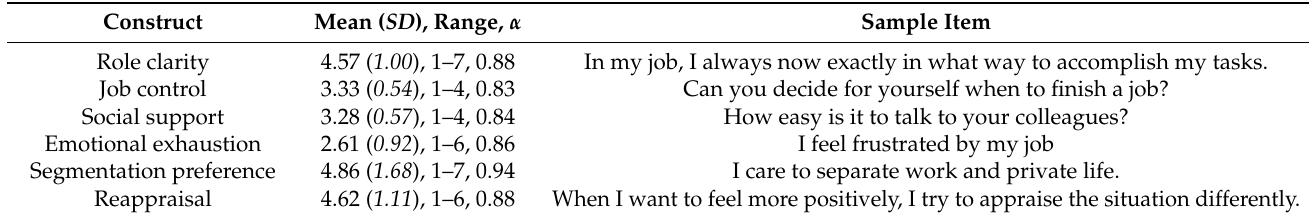
Table 2. Resources of the individual and the job (Section